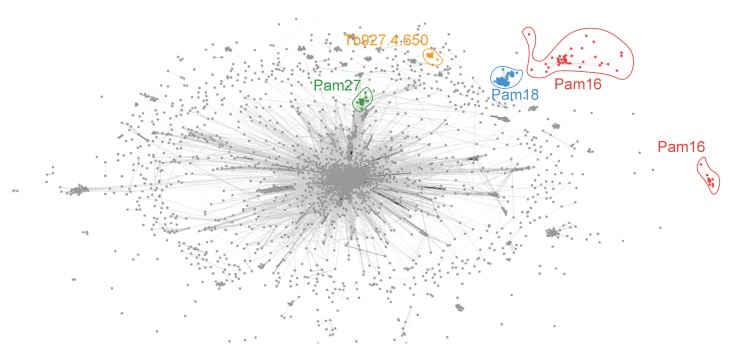
Similarity network of the J protein superfamiliy clustered with a P-value threshold of 1 × 10−20.Similarity network of DnaJ and Pam16 domain-containing proteins clustered by CLANS with a P-value threshold value of 1 × 10−20. By lowering the P-value threshold the central tight cluster disassembles to some degree and reveals some of its substructure. The Pam18 (blue), TbPam27 (green) and Tb927.4.650 (orange) clusters remain cohesive. The Pam16 (red) family is now found as two distinct clusters representing most eukaryotes and kinetoplastids.